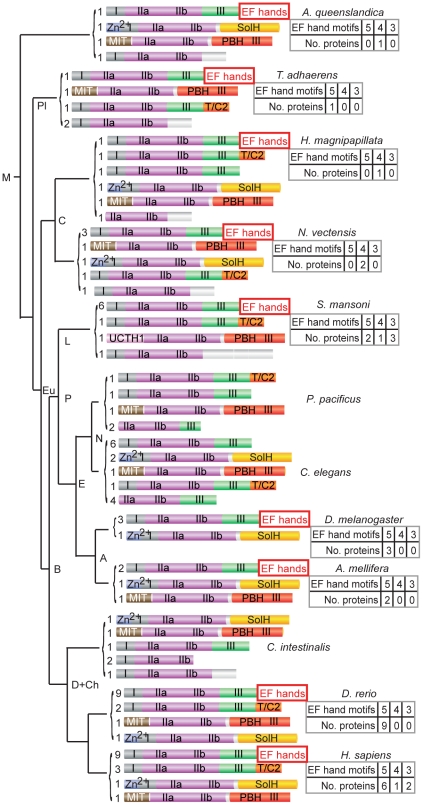
Phylogenetic analyses of typical calpains in metazoa support a model of lineage-specific loss.Typical calpain EF hand motifs in DIV are highlighted; C-terminal EF hand motifs are absent in Nematoda and Ciona intestinalis. Other domains associated with calpain proteins include: PBH, PalB homology domain with some domain III homology; T/C2, C2 domain originally identified in TRA-3 [33]; Zn2+, zinc finger motif-containing; SolH, small optic lobes (SOL) homology domain; MIT 1, microtubule interacting and transport domain; and UCTH1, ubiquitin carboxyl-terminal hydrolase domain. The number of genes encoding proteins with the indicated modular arrangement of domains is indicated, left; the number of EF hands in DIV predicted by custom profile hidden Markov models are shown, right. Clades abbreviations: M, Metazoa; Pl, Placozoa; Eu, Eumetezoa; C, Cnidaria; B, Bilateria; P, Protostomia; D+Ch, Deuterostomia and Chordata; L, Lophotrochozoa; E, Ecdysozoa; N, Nematoda and A, Arthropoda. The tree is not drawn to scale. Protein accession numbers are available in Materials and Methods.